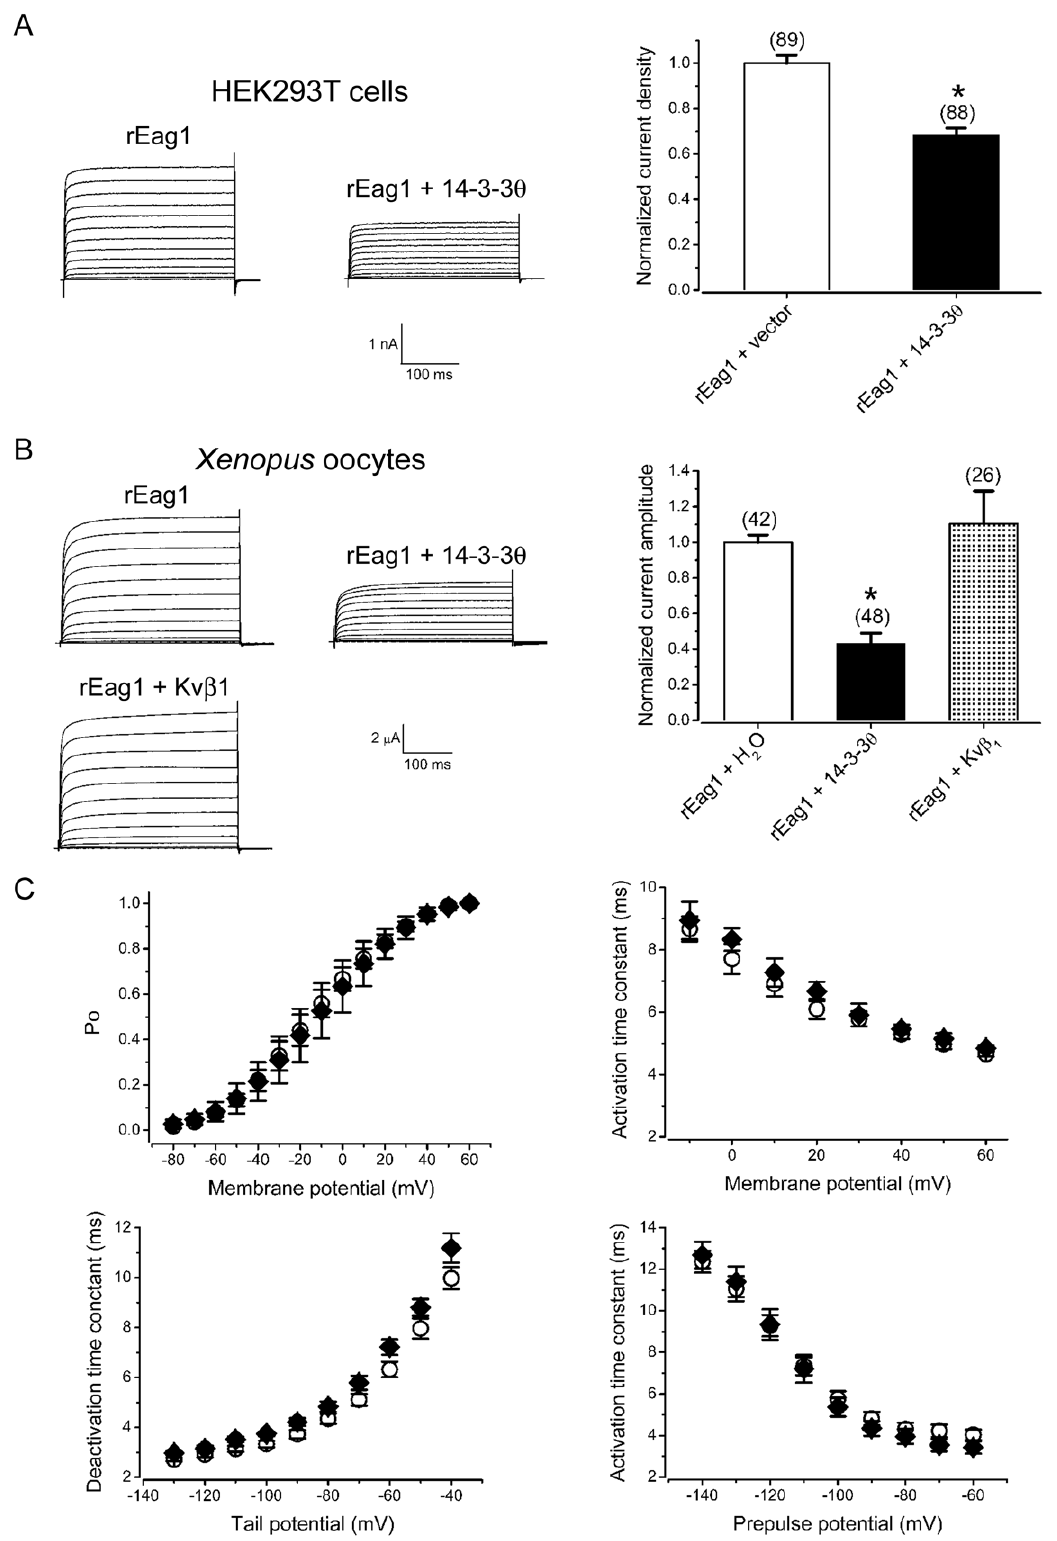
Figure 7. The effect of 14-3-3 h over-expression on rEag1 K + currents. ( A ) ( Left panel ) Representative K + currents recorded from HEK293T cells expressing rEag1 in the absence or presence of 14-3-3 h . HEK293T cells were co-transfected with the cDNAs for rEag1 and myc-vector or myc-14-3-3 h in the molar ratio of 1:5. The holding potential was 2 90 mV. The pulse protocol comprised 300-ms depolarizing test pulses ranging from 2 90 to + 50 mV, with 10-mV increments. ( Right panel ) Normalized mean K + current density (at + 40 mV) of rEag1 channels in the absence or presence of myc- 14-3-3 h . The numbers in the parentheses refer to the number of cells analyzed, and the asterisk denotes significant difference from the rEag1 control